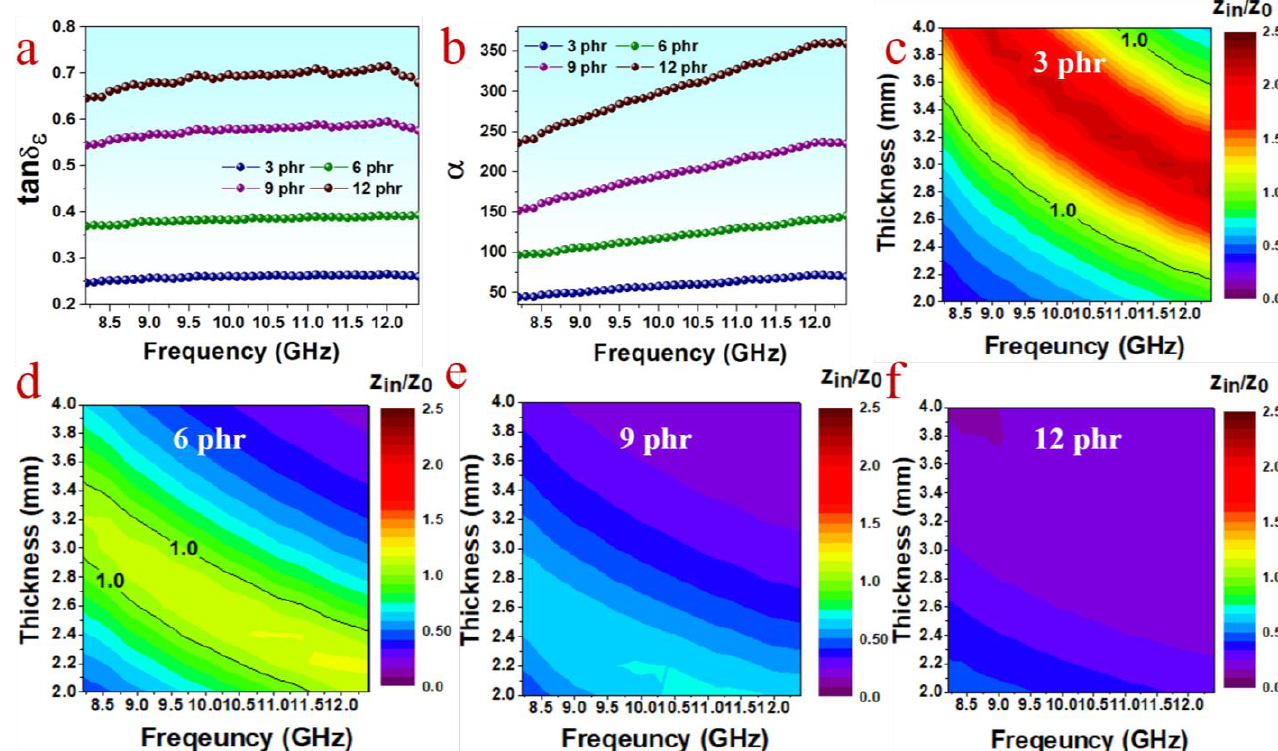
Figure 3. ( a ) Dielectric loss tangent factor, ( b ) attenuation constant and ( c – f ) 2D contour maps of | Z ⁄ | values for PPyNT/NBR/NBR (50/50) with different PPyNT contents. in Z 0